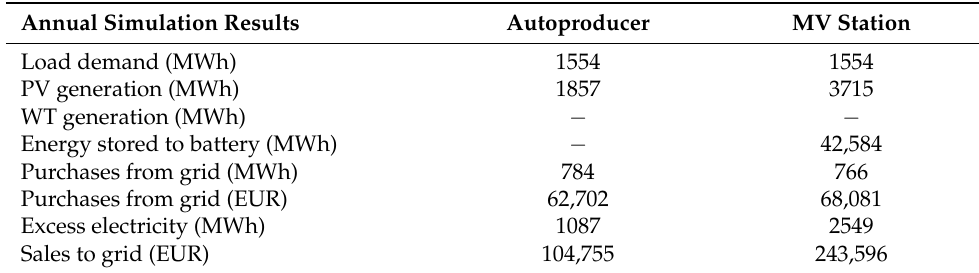
Table 7. Annual results of the HMU campus microgrid operation for optimal